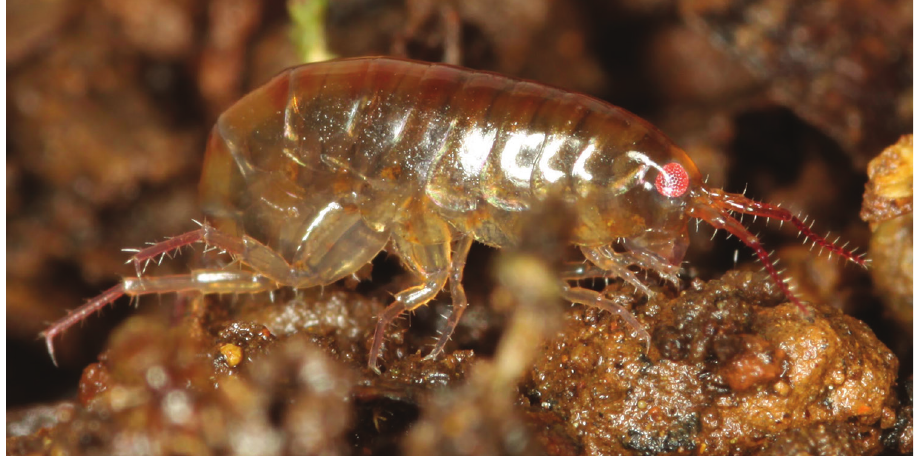
Figure 1. Life photo of Myanmarorchestia peterjaegeri Hou, sp. n., one of the female paratypes, photo courtesy of Peter